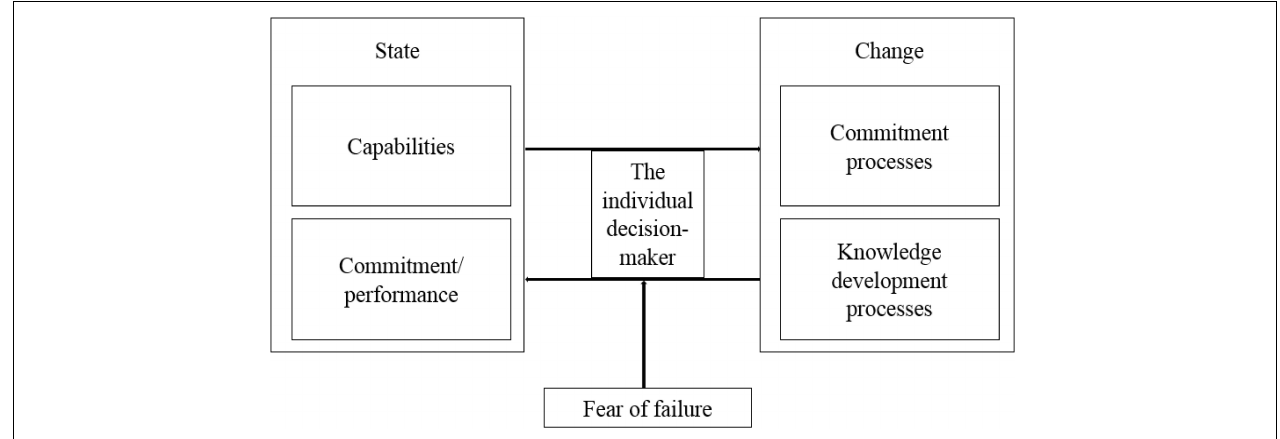
FIGURE 2 | The conceptual model: building the link between fear of failure and the process of